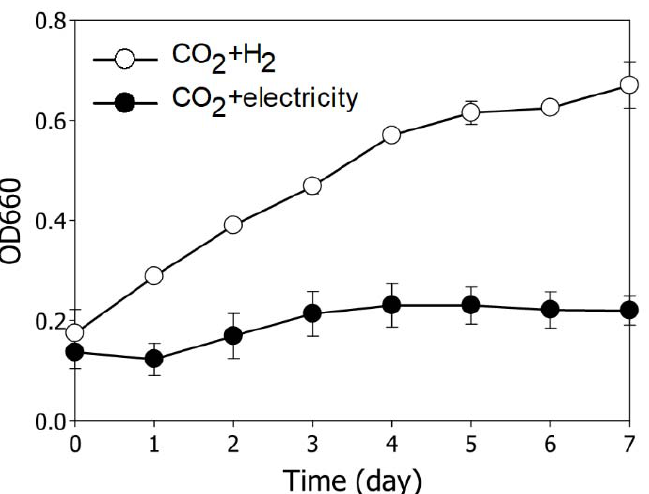
Figure 1. Comparison of growth characteristics according to different reducing power sources in R. sphaeroides . The cells were cultured using CO 2 and light, and only the reducing power source was varied. The white circle line denotes CO 2 + H 2 , which represents normal photoautotrophic cultivation. The black circle line denotes CO 2 + electricity, which represents MES cultivation. The experiments performed in triplicate and error bars indicate the standard deviation of the mean.